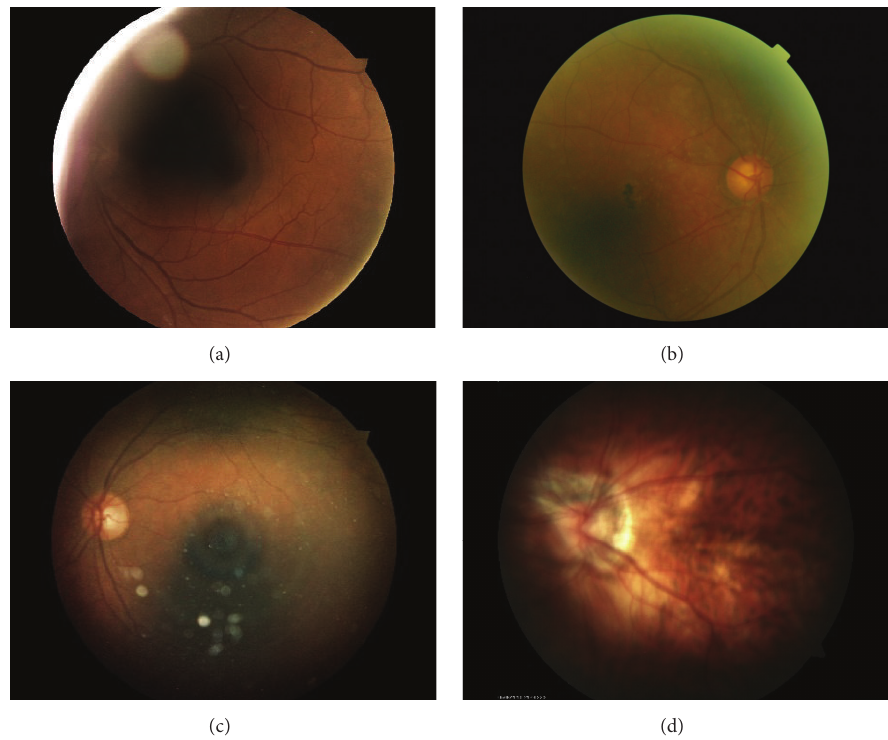
Figure 3: Examples of poor quality images: (a) shadows and intense reflections, (b) haze, (c) arc and specular reflections, and (d) blur.